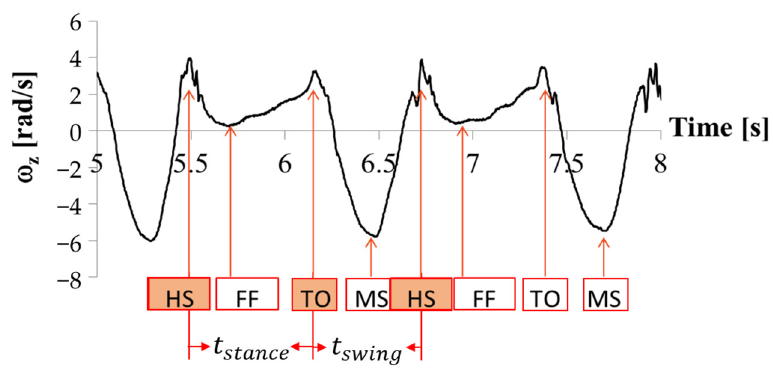
Figure 9. The motion data example of angular velocity for one foot.